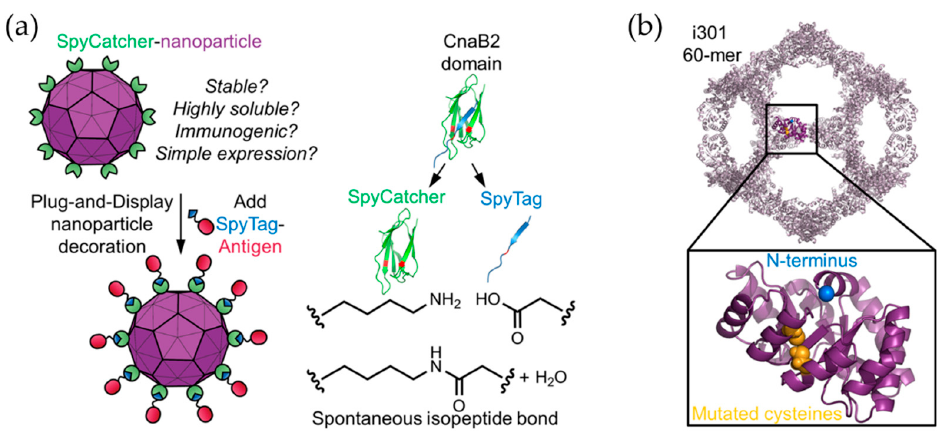
Figure 7. i301 as a platform for antigen display. ( a ) An illustration of a Plug-and-Display system using SpyCatcher-i301 and a SpyTag-antigen. ( b ) Modification of the i301 carrier, C76 and C100 in i301 (yellow), which were mutated to alanine to produce the mi3 nanoparticle platform. Reprinted with permission from [70]. Copyright (2018) American Chemical Society.